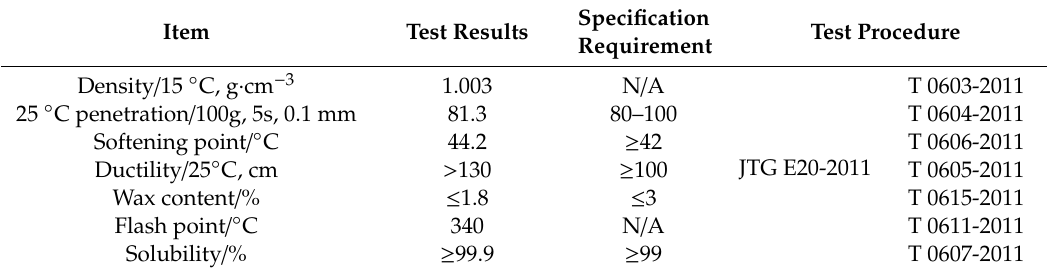
Table 1. Technical parameters of AH-90# “Panjin” base asphalt.